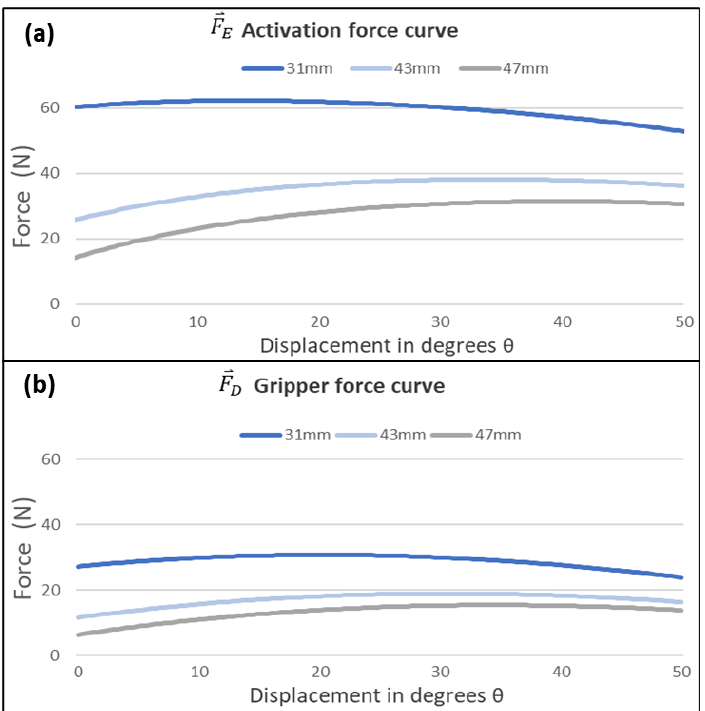
Figure 5. ( a ) Activation force curve and ( b ) gripper force curve for unstretched band lengths of 31 mm, 43 mm, and 47 mm. Note: curves do not represent continuous measurement but discrete interpolated samples.